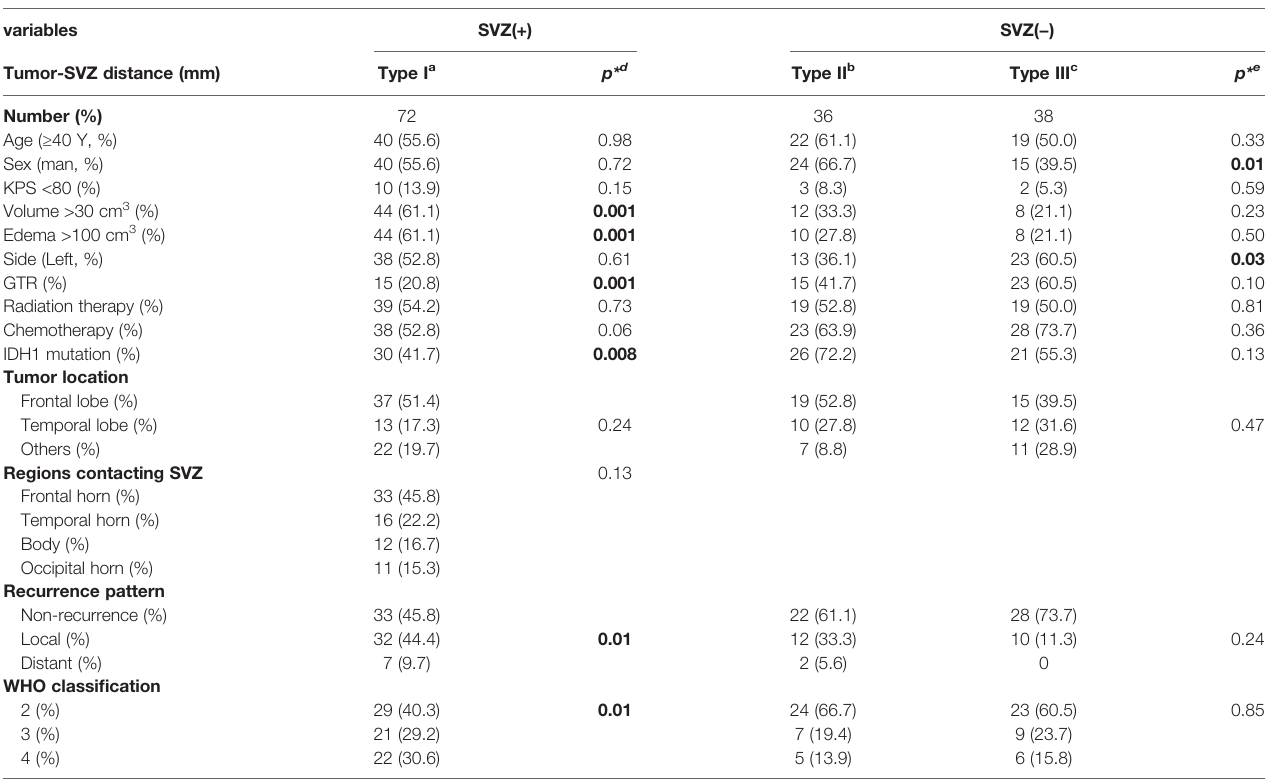
TABLE 1 | Clinical characteristics (n =